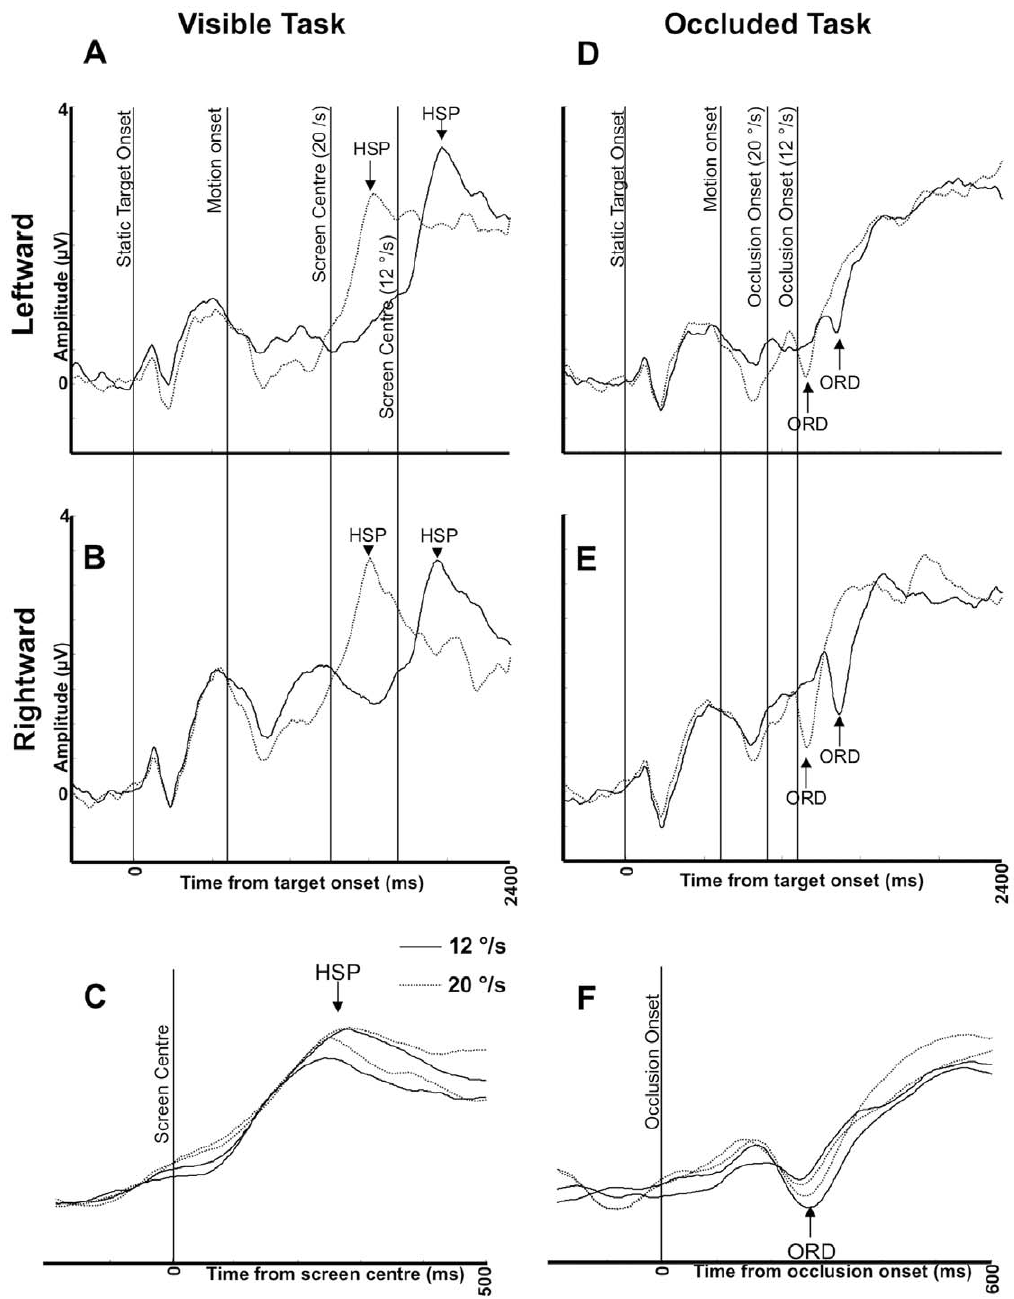
Figure 3. Event Related Potentials (ERPs). A) ERPs in the left cluster, leftward motion conditions of the Visible Task. B) ERPs from the right cluster, rightward motion conditions of the Visible Task. C) The Hemifield Switch Positivity (HSP) component in the Visible Task. Waveforms are realigned to the time the target passed the fixation cross, and baseline corrected to a 200 ms interval before this. D) ERPs in the left cluster, leftward motion conditions of the Occluded Task E) ERPs in the right cluster, rightward motion conditions of the Occluded Task. F) The Occlusion Related Deflection (ORD) component in the Occluded task. Waveforms are realigned to occlusion onset and baseline corrected to a 200 ms pre -occlusion interval. All ERP plots are smoothened with a 20 Hz filter and vertical lines illustrate events during the trial. doi:10.1371/journal.pone.0038479.g003 (83% vs. 44%, F (1, 17) = 264.12, p , 0.001). This confirms that participants were covertly tracking the occluded targets. Again, sequential topographic maps were aligned according to time from motion onset (Figure 2B). As for the Visible Task, posterior positive ERPs were lateralized according to motion direction, but the timing of the ERPs was different. In the